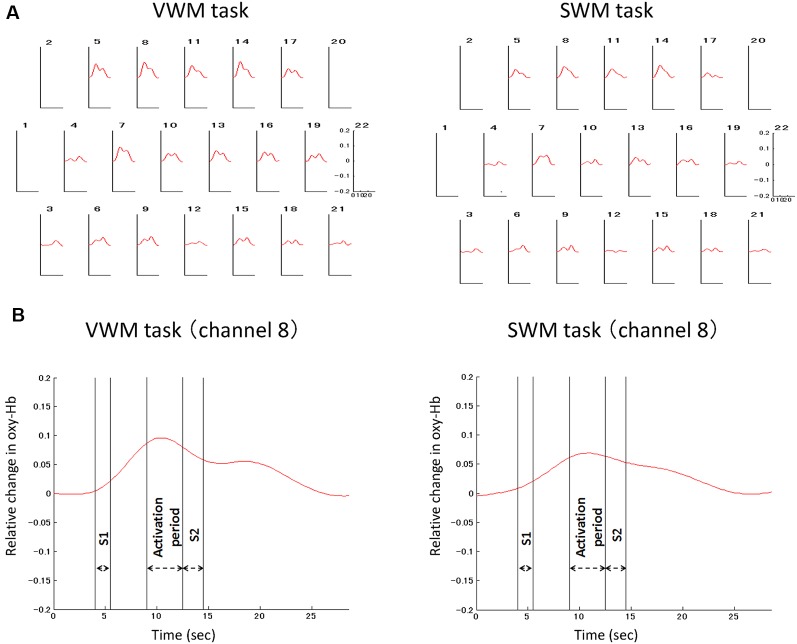
Grand average waveform of the task-related oxygenation process. Signal-averaging was applied to depict the task-related oxygenation response at each channel across all analyzed participants (A). In the oxygenation process at the representative channel (channel 8), double-headed arrows indicate the target stimulus (S1) period, activation period, and the probe (query) stimulus (S2) period (B). VWM, Verbal working memory; SWM, spatial working memory.